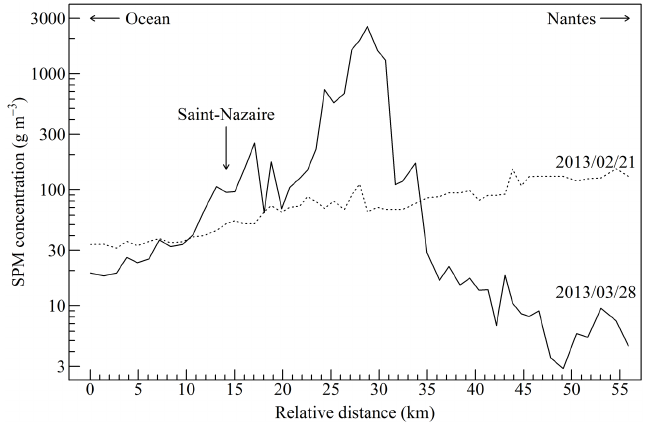
Figure 8. SPOT4-derived longitudinal transect of suspended particulate matter (SPM) surface concentration in the Loire estuary on 21 February 2013 (dotted line) and 28 March 2013 (solid line).